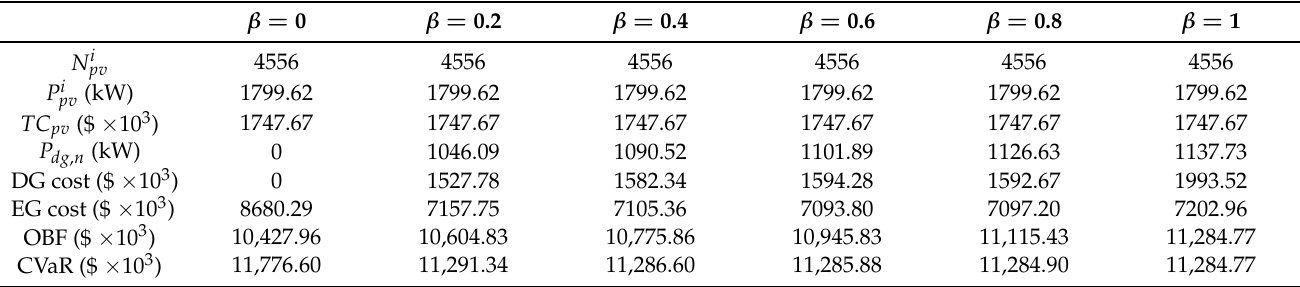
Table 8. Results for the most severe flag.